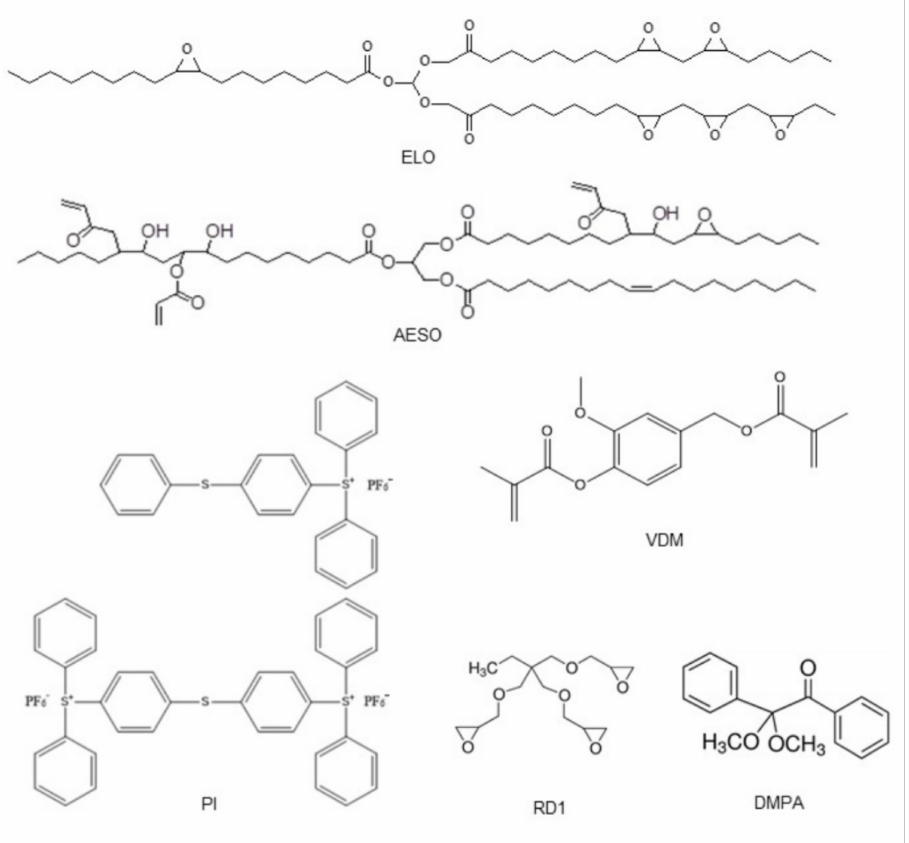
Figure 1. Chemical structures of epoxidized linseed oil (ELO), acrylated epoxidized soybean oil (AESO), trimethylolpropane triglycidyl ether (RD1), vanillin dimethacrylate (VDM), triarylsulfonium hexafluorophosphate salts (PI), and 2,2-dimethoxy-2-phenylacetophenone